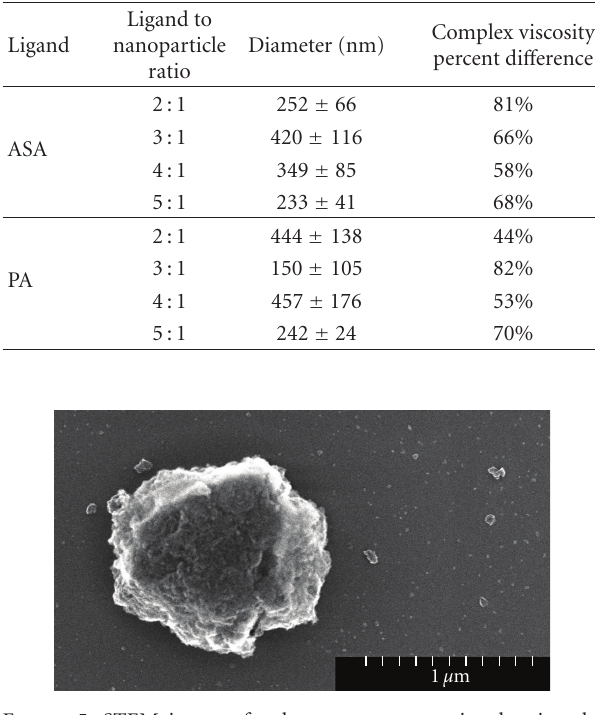
Figure 5: STEM image of polymer nanocomposite showing the presence of 50–1000 nm ligand capped Tb 3+ :LaF 3